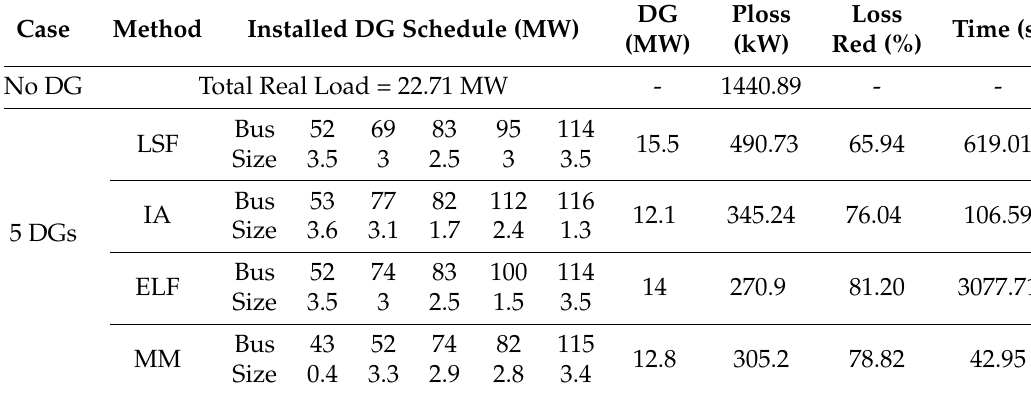
Table 3. DG placement by different methods for IEEE 119 node system at operational power factor.